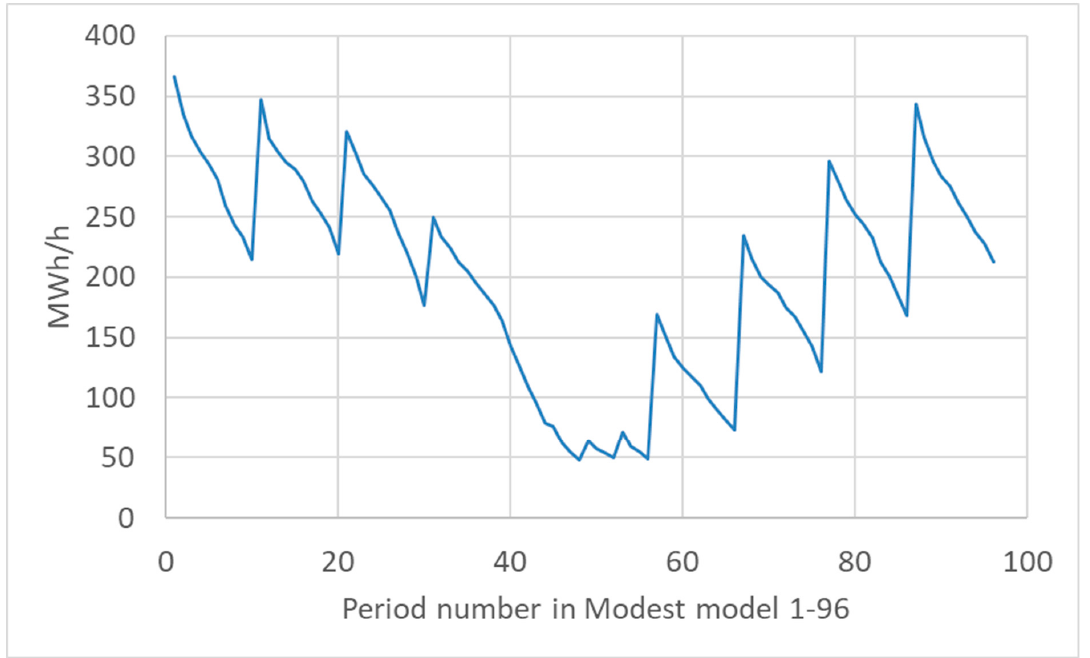
Figure 6. Heat load in the model, presented with monthly duration diagram (i.e., days sorted by heat load in each month). For days with higher heat loads are modelled in greater detail, see Table 4.